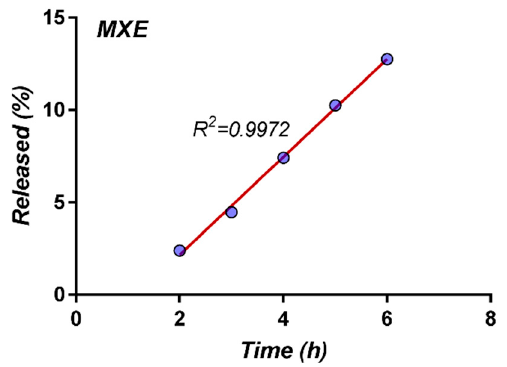
Figure 14. Kinetic modeling of the MXE release profile using zero order kinetics.